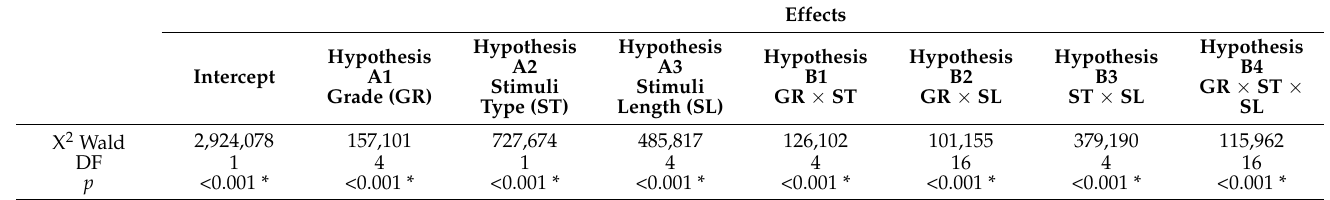
Table 3. Effects test for each GEE factors for accuracy and percentage of correct responses according to the hypotheses of the